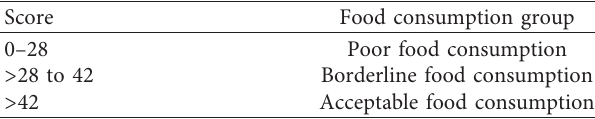
Table 4: World food programme food consumption score 1